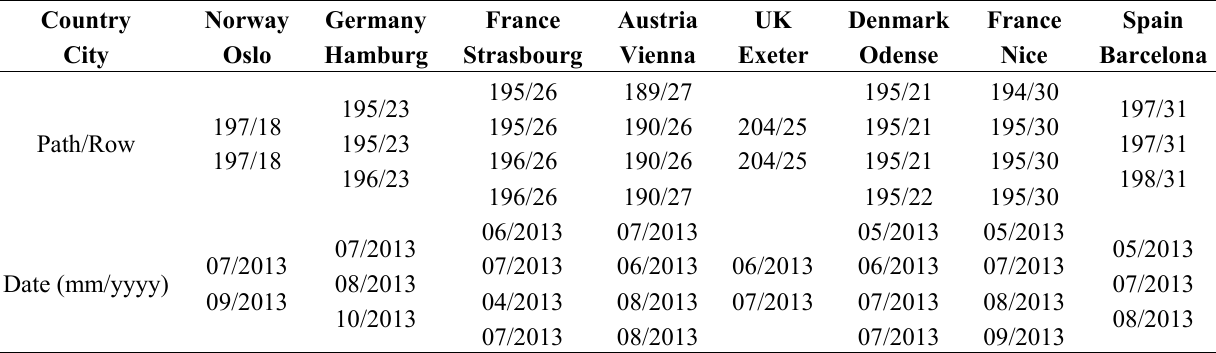
Figure 1. Location of case cities within major terrestrial ecoregions in Europe [19]. Table 1. Landsat 8 image paths, rows and acquisition